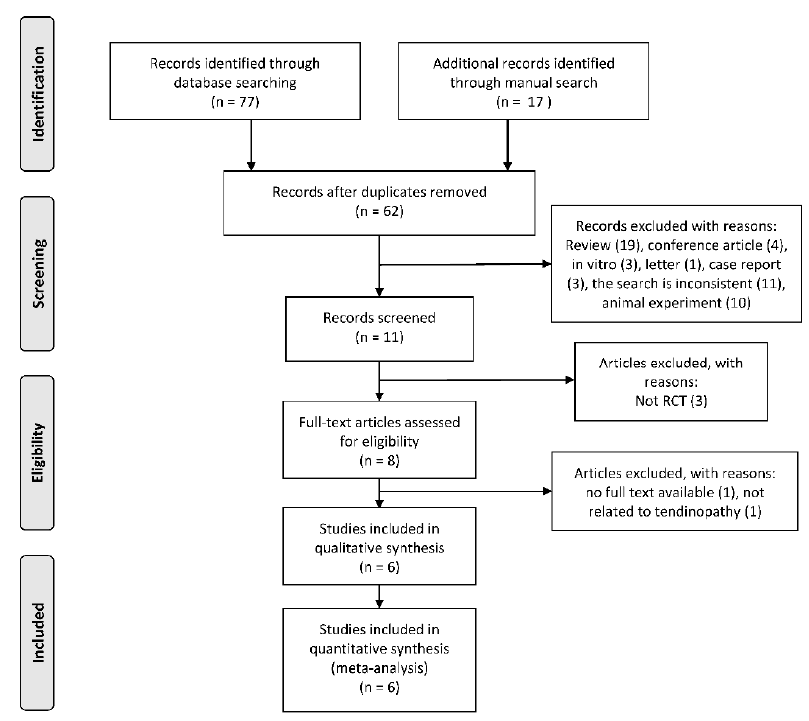
Figure 1. Study selection process (according to the PRISMA